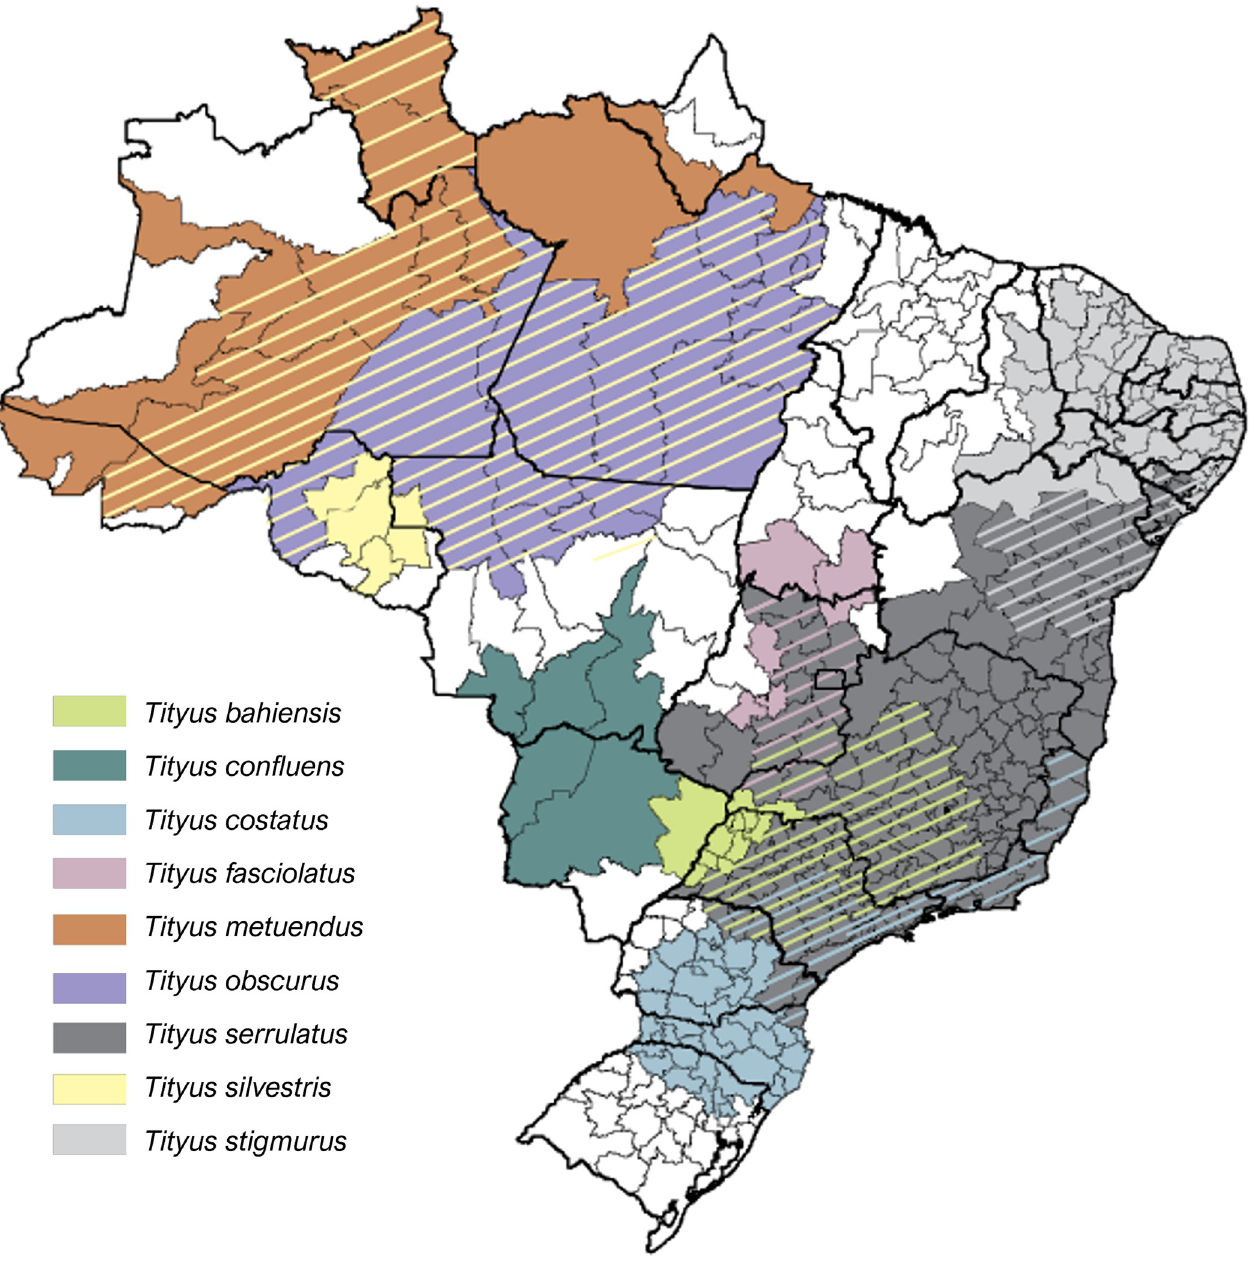
Fig 4. Distribution of the medically relevant Tityus scorpion species in Brazilian territory. Species’ distribution information was adapted from [69]. The map figure was produced using QGis software. The Brazilian map’s shapefile was downloaded from the Instituto Brasileiro de Geografia e Estatı´stica–IBGE website (https://portaldemapas.ibge.gov.br/).